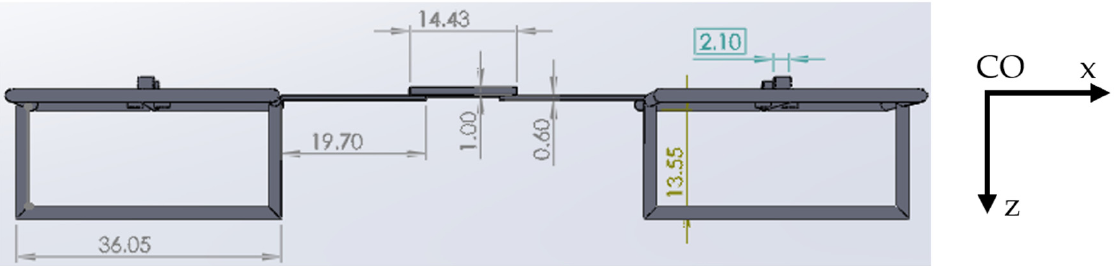
Figure 6. Profile view of the model (dimensions in cm) (developed with SolidWorks [60]).